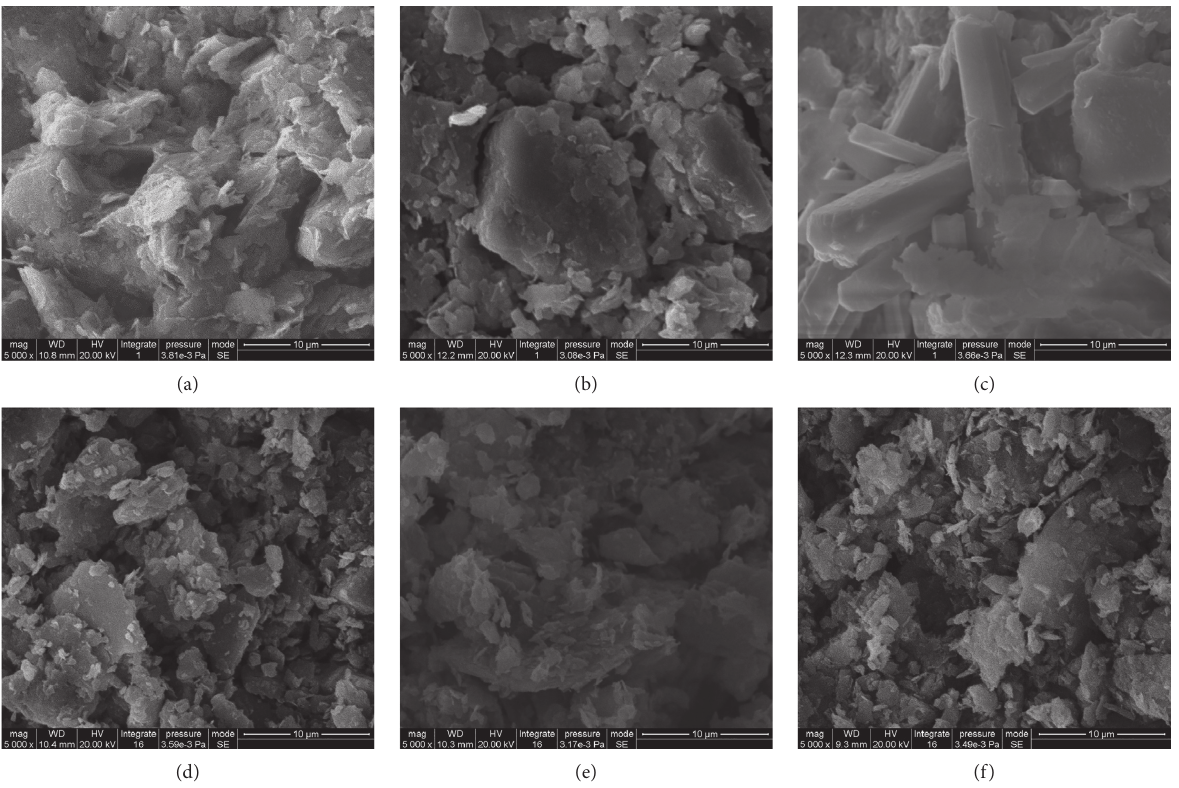
Figure 8: Scanning electron micrographs of the soil sample at the anode before and after the electro-osmosis process (5000x